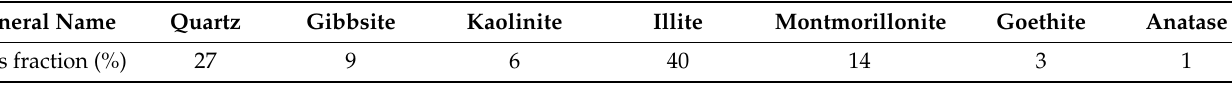
Table 1. The mineral composition of the silty clay.